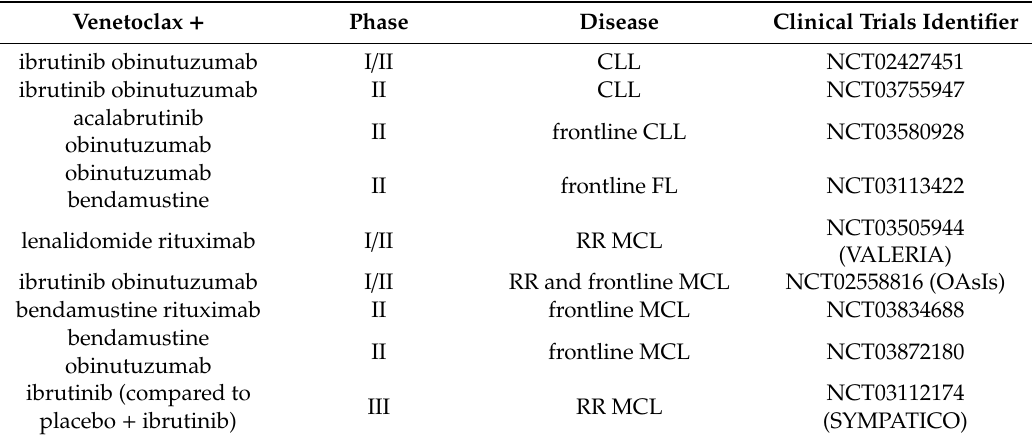
Table 2. Selected ongoing clinical trials evaluating venetoclax in combination for the treatment of mature B-cell malignancies excluding multiple myeloma